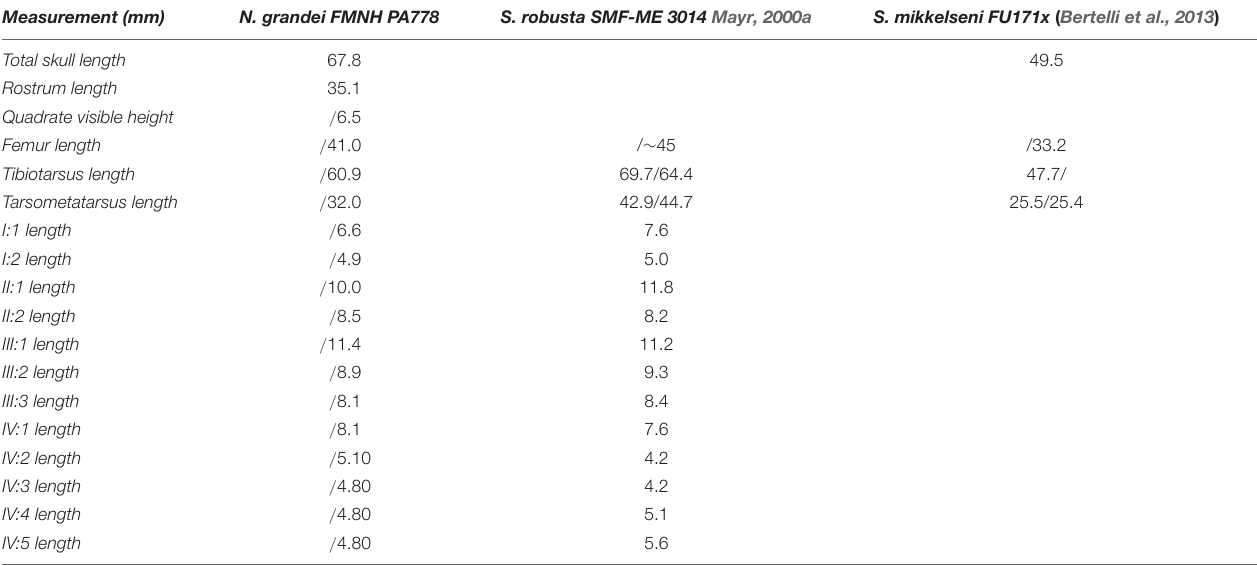
FIGURE 1 | Photograph (A) and line drawing (B) of FMNH PA778. Bone is unfilled, matrix is gray, cartilaginous tracheal and possible syringeal rings are shown in light gray, and feathers and other unidentifiable soft tissue is displayed in dark gray. Extremely crushed bone and bone margin is delimited with dashed margins. Anatomical abbreviations: prx, premaxilla; com, crest-like orbital margin; scl, scleral rings; qdr, quadrate; mnd, mandible; jug, jugal; hyd hyoid; cvt, cervical vertebrae; cpr, costal processes; thv, thoracic vertebra; cdv, caudal vertebra; pub, pubis; pyg, pygostyle; rib, ribs; unc, uncinate process; ili, preacetabular ilium; isch, postacetabular ischium; pub, pubis; fem, femur; tbt, tibiotarsus; tmt, tarsometatarsus; mtII, trochlea metatarsal II; mtIII, trochlea metatarsal III; mtI, metatarsal I; I:1, hallux; II:1, phalanx one of digit II; III:1, phalanx one of digit III; IV:1, phalanx one of digit IV; clw, claw; thr, tracheal rings. TABLE 2 | Selected measurements of Nahmavis grandei in millimeters (mm), taken from surface of slab (does not include CT scan measurements; left/right) compared with previously published measurements of Salmila robusta and Scandiavis mikkelseni